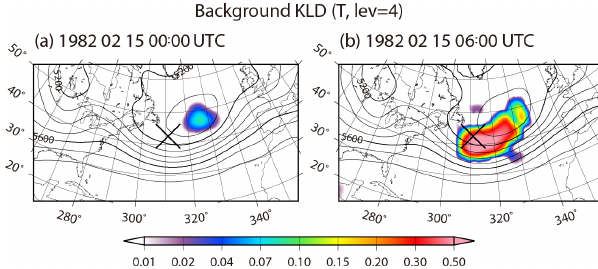
Figure 14. Spatial distributions of the KL divergence for back- ground temperature at the fourth model level ( ∼ 500hPa) (a) at 00:00UTC on 15 February and (b) at 06:00UTC on 15 Febru- ary. Contours show geopotential height of the ensemble mean at the 500hPa level.